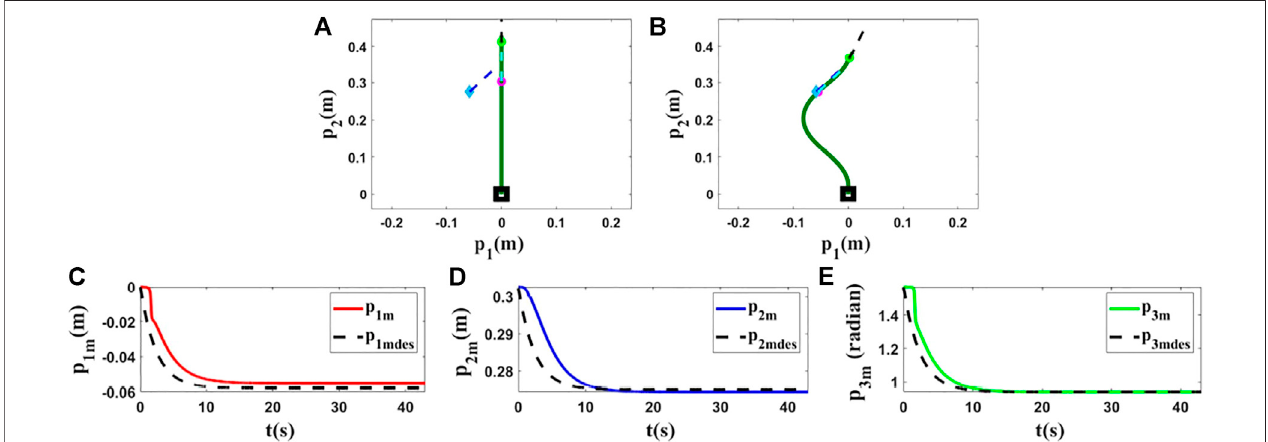
FIGURE7| Simulation 5.Firstrow: (A) and (B) aretheinitialand fi nalshapeoftheobject,respectively.Thedesiredstateofthepoint m isshown asabluediamond (position) and a dashed line segment (orientation). L = 0.43( m ), M 0 = [0.0000, 0.3000, 1.5708] T , and M fdes = [ − 0.0579, 0.2750, 0.9406] T . After applying the proposed controller to this model, the fi nal state of the controlled point is [ − 0.0550, 0.2744, 0.9452] T . Second row: (C) , (D) and (E) are the states of the controlled point based on the desired trajectories in the fi fth simulation using the ARAP model.